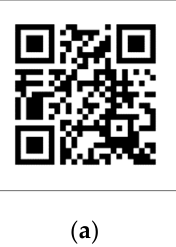
(cid:12) (cid:12) (cid:12) = 15,471, (cid:12) W 0 15471 W = 0